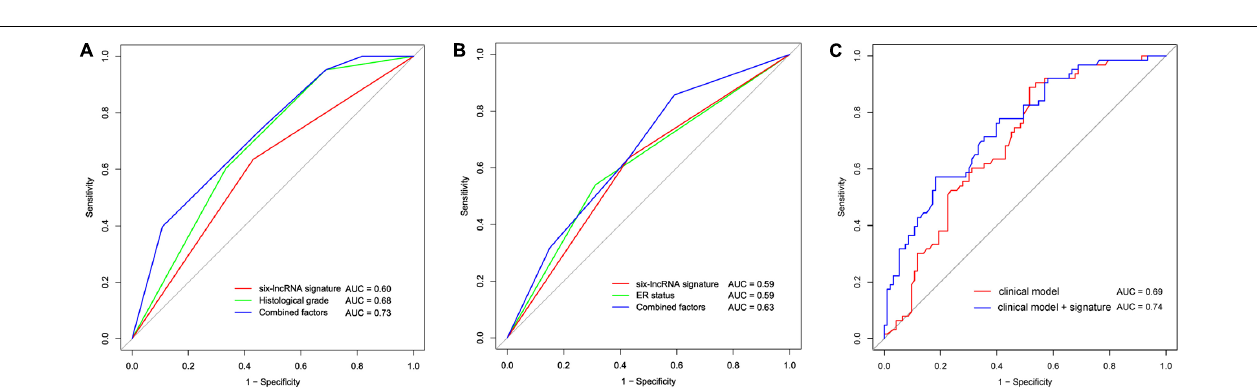
FIGURE 5 | Kaplan–Meier curves of the disease-free survival according to low-risk or high-risk scores, stratified by tamoxifen therapy in an independent cohort (GSE19615, n = 115). (A) Patients with tamoxifen therapy (red) had significantly longer disease-free survival than patients without treatment (blue) in the low-risk group. (B) Patients who received tamoxifen therapy (red) and those who did not (blue) showed no survival differences in the high-risk group.